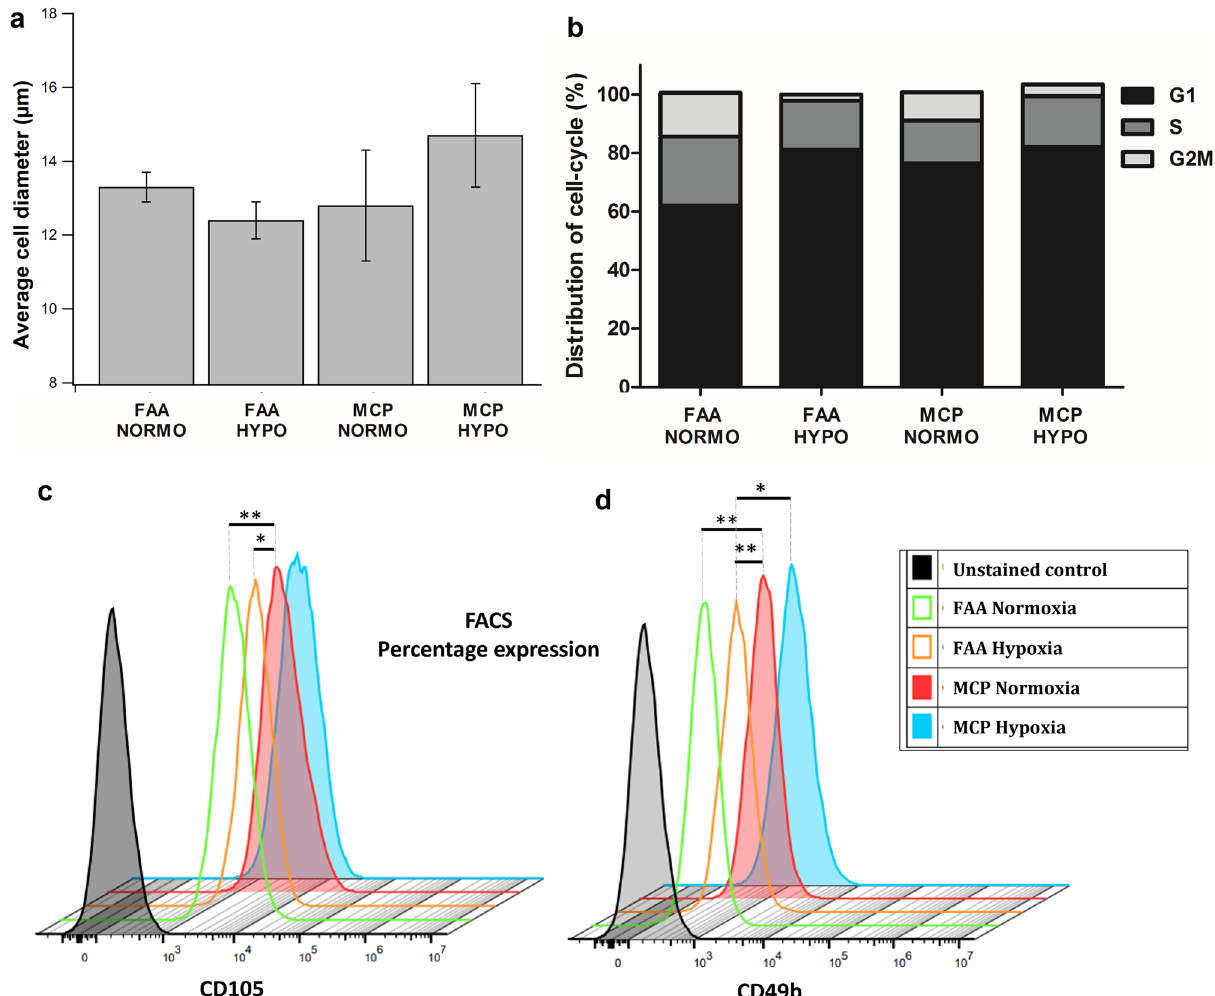
Figure 3. ( a ) Analysis of the average cell diameter (µm) of passage 1 chondroprogenitors showed that hypoxia MCPs and normoxia FAA-CPs displayed greater diameter than their counterparts although not statistically significant. ( b ) Analysis of the different phases in cell cycle distribution between the groups showed that both FAA-CPs and MCPs grown under hypoxia displayed a greater percentage at G1 interphase and lower percentage at G2M interphase as compared to their normoxic counterparts. However, when the DNA synthetic S phase was compared the highest values were observed with normoxia FAA-CPs. ( c ) To characterize the surface marker expression profile, FAA-CPs and MCPs cultured under normoxia and hypoxia were subjected to fluorescence-activated cell sorting. All groups revealed comparable expression of CD markers (Table 1) except for CD105 and CD49b ( c and d : staggered plot). MCP-Normoxia expressed significantly higher levels of both CD105 and CD49b when compared to both FAA-CP-Normoxia and FAA-CP-Hypoxia ( P < 0.01). In